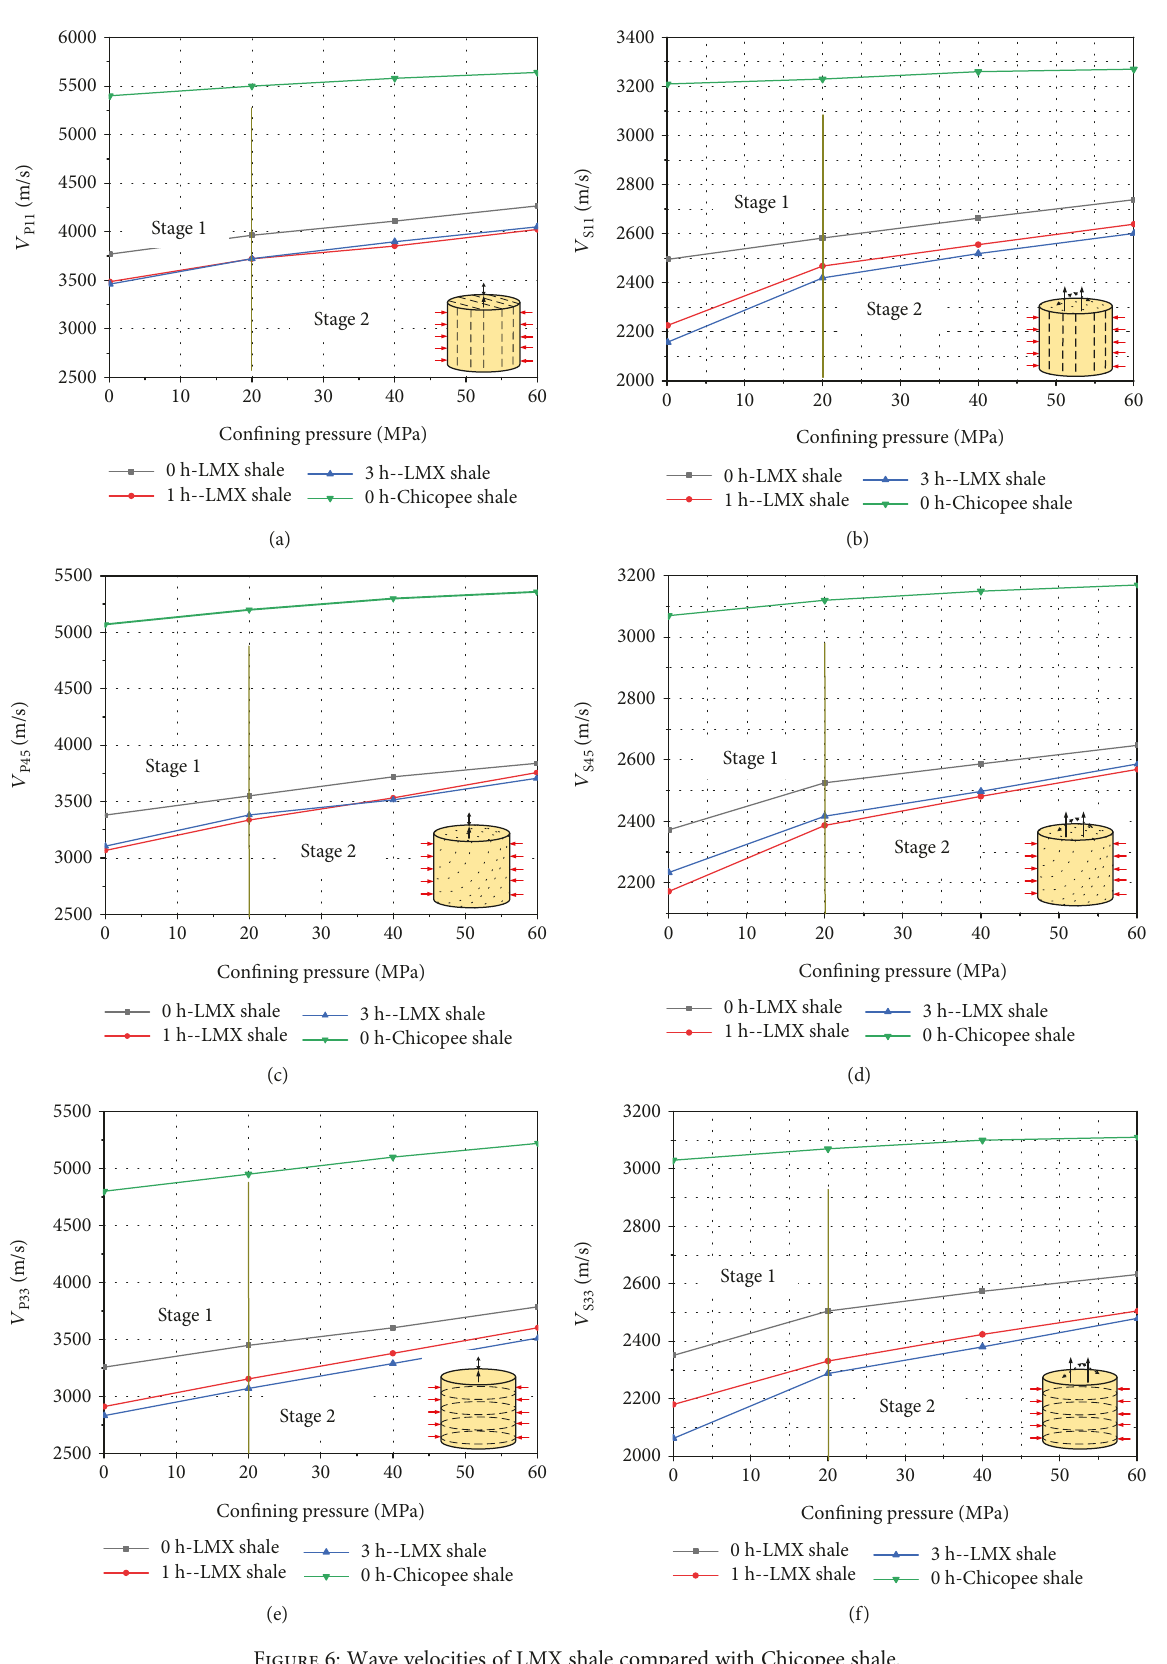
Figure 6: Wave velocities of LMX shale compared with Chicopee